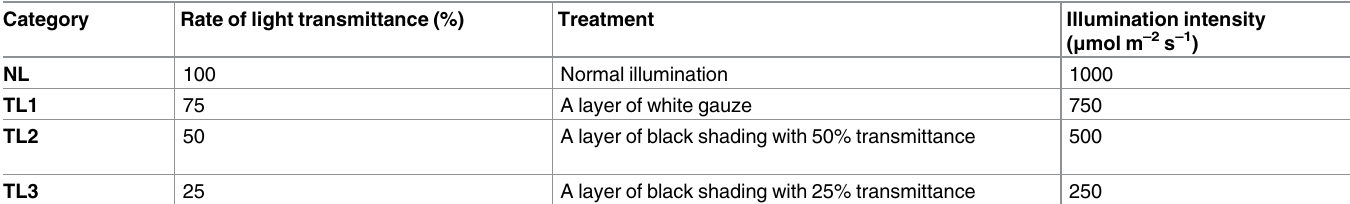
Table 1. Low light treatment of purple pak-choi seedlings in a phytotron. Category Rate of light transmittance